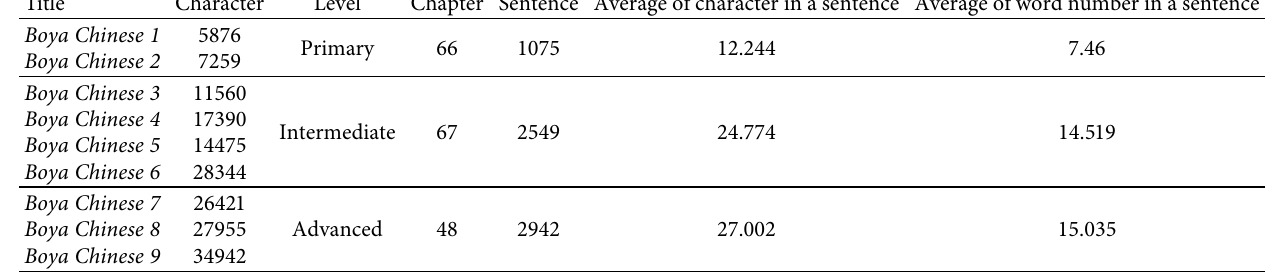
Table 3: Boya Chinese.